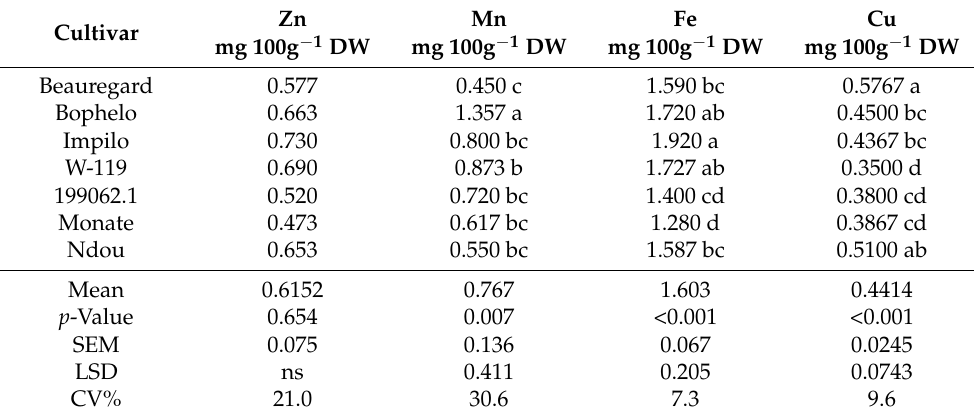
Table 5. Micro-elements contained by sweet potato cultivars with varying flesh colors.